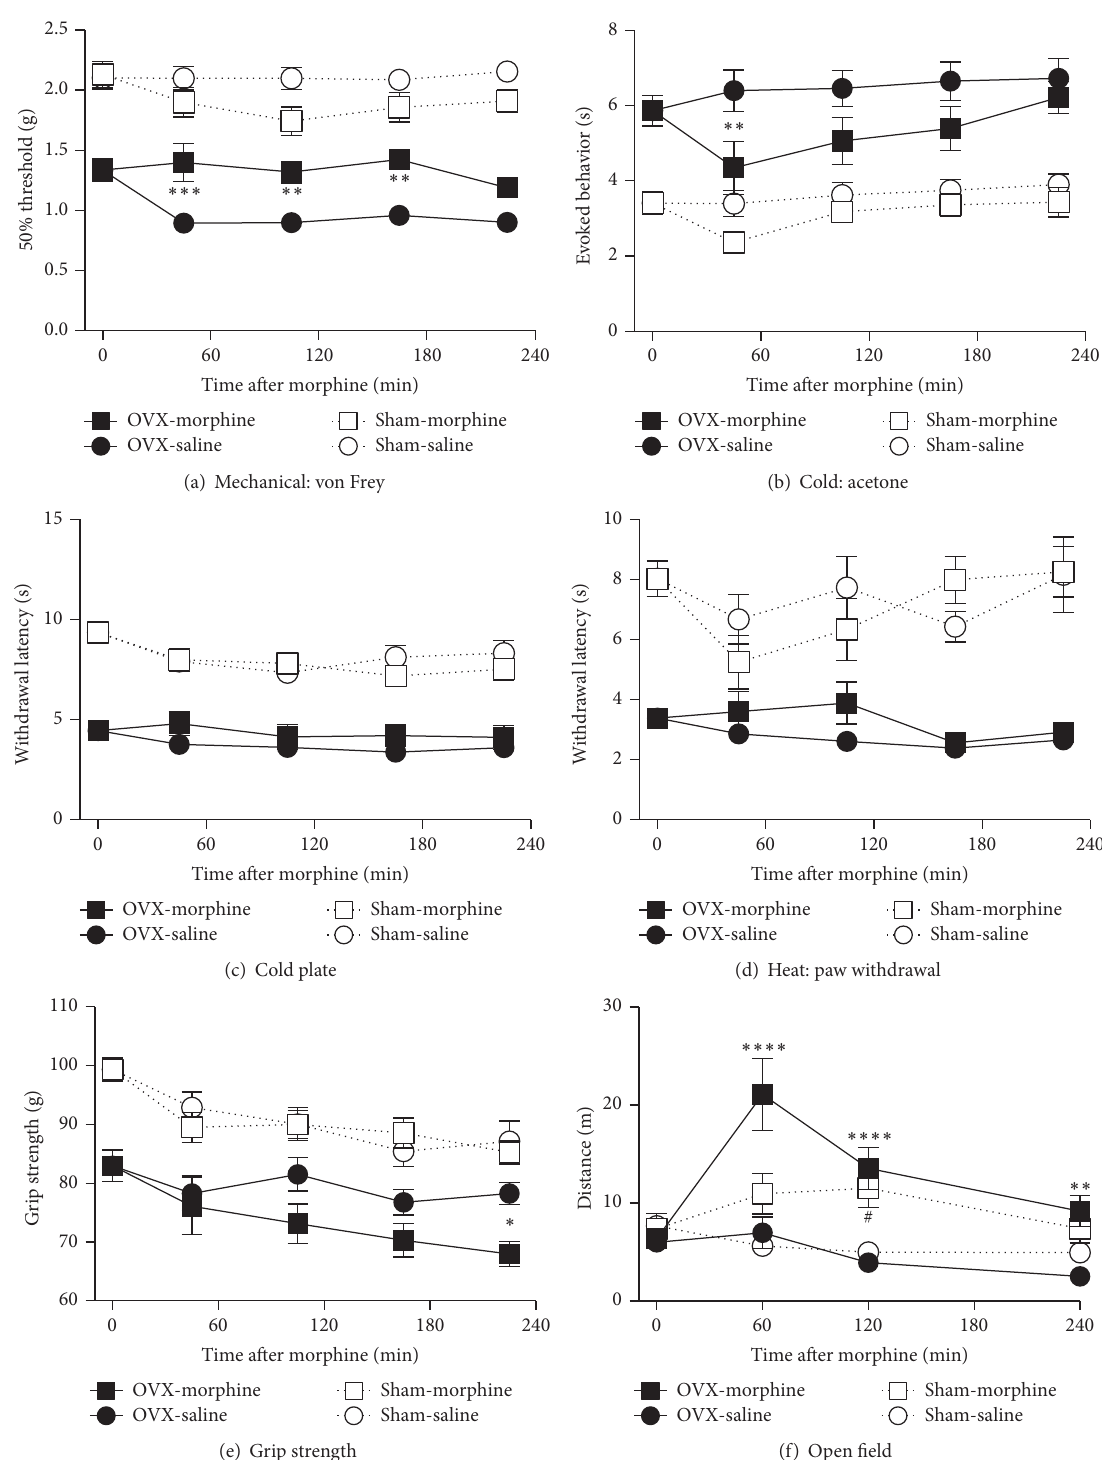
Figure 5: Efficacy of acute morphine treatment on chronic osteoporosis-related cutaneous and musculoskeletal pain and physical function. The effect of an acute intraperitoneal injection of morphine (10mg/kg) was measured for several hours in mice, 6 months after ovariectomies or sham surgeries. In ovariectomized (OVX) mice, morphine results in a significant reduction in mechanical hypersensitivity (von Frey assay) that persists for several hours (a) and reduces cold hypersensitivity (acetone test) (b). No effects are evident in the cold plate (c), radiant heat paw withdrawal (d), or grip strength (e) assays. Morphine increases the OVX animals’ overall activity in the open field test (f). No effects are seen in the sham-operated mice. Data are expressed as means ± standard error of the mean. ∗ 𝑃 < 0.05 ; ∗∗ 𝑃 < 0.01 ; ∗∗∗ 𝑃 < 0.001 ; ∗∗∗∗ 𝑃 < 0.0001 ; OVX group with morphine versus vehicle, # 𝑃 < 0.05 ; and sham-operated group with morphine versus vehicle, two-way repeated measures analysis of variance (factors = group × time), followed by Tukey’s test for multiple